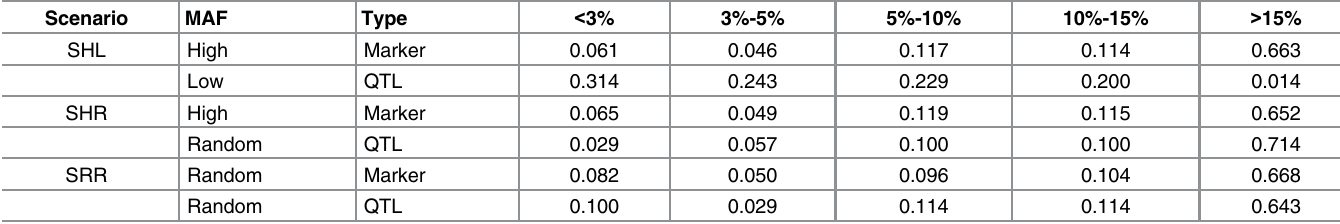
Table 1. Percentage of SNPs in a particular range of